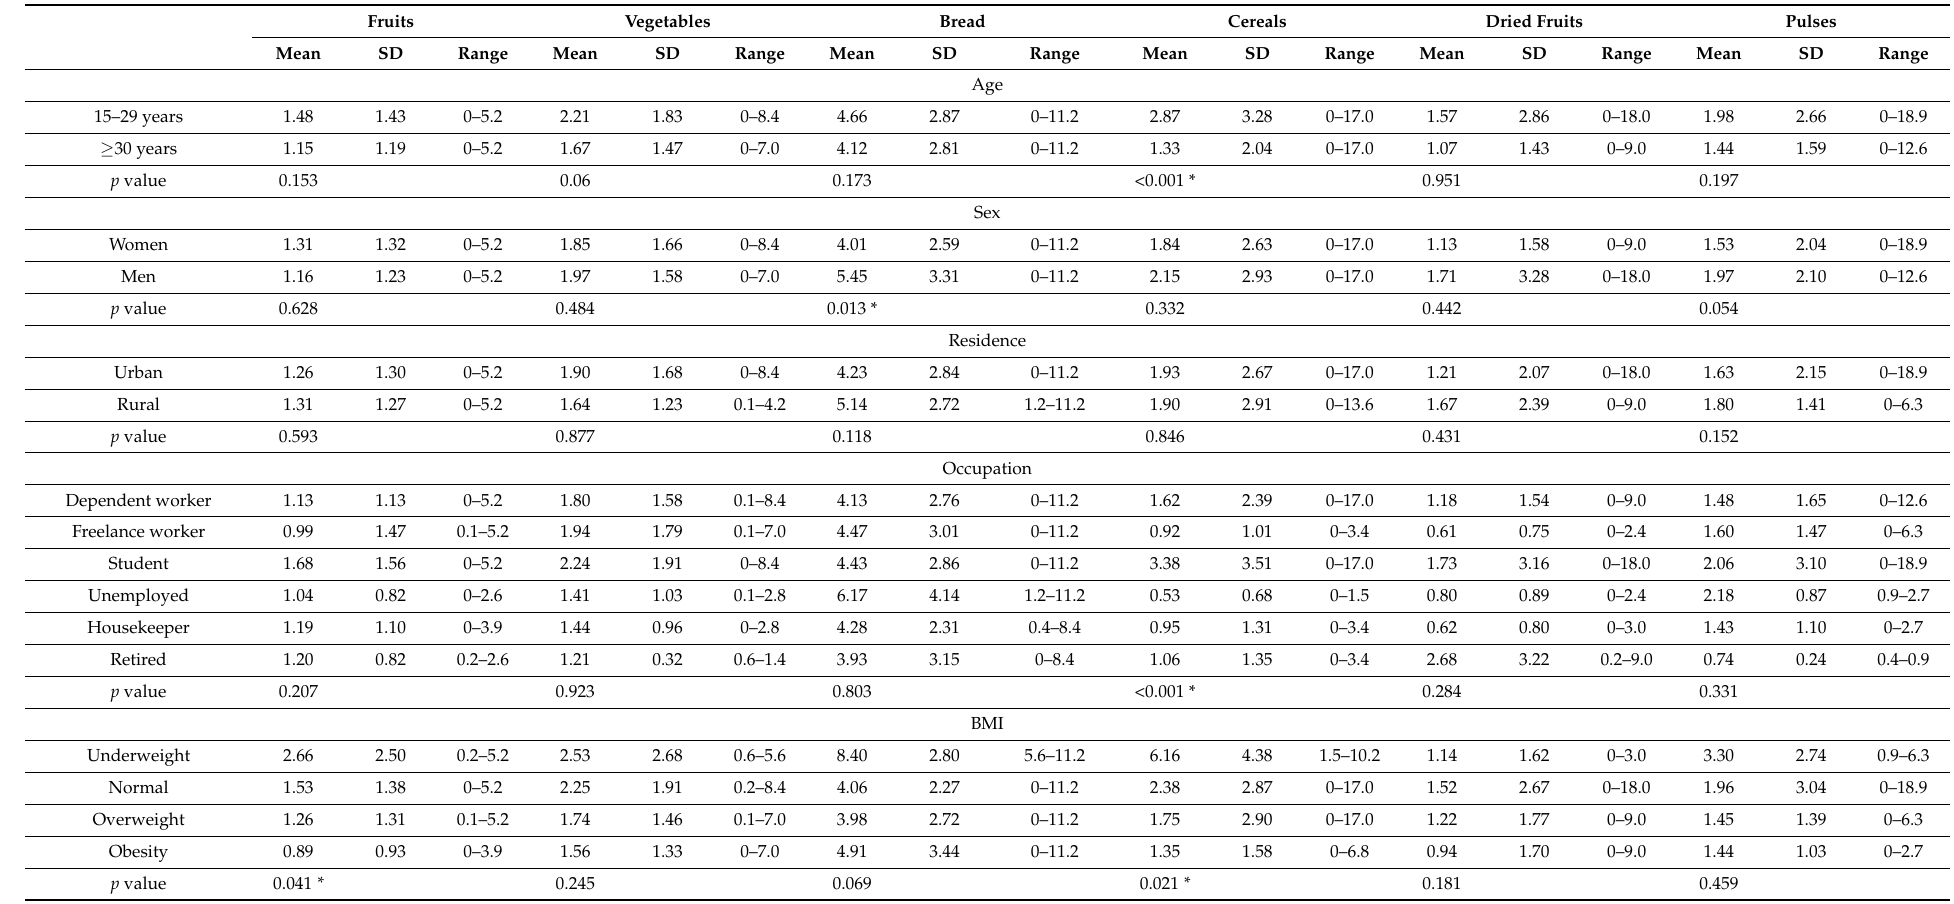
Table 4. Description of fiber intake (g/day) by food groups ( n =